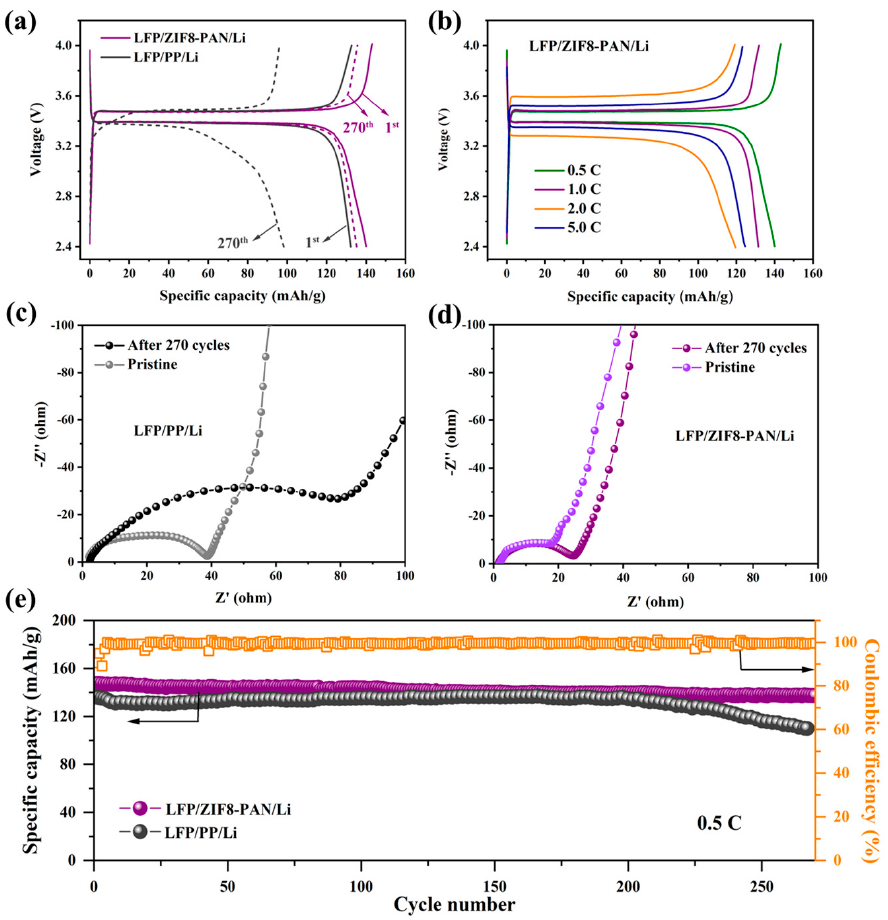
Figure 7. The electrochemical performances of Li//LiFePO 4 full cells assembled with PP and ZIF8-PAN separators. ( a ) Voltage profiles for the first and 270th cycle at 0.5 C. ( b ) Charge/discharge performance of ZIF8-PAN-based full cells under different current densities. ( c , d ) EIS results of pristine and cycled full cells. ( e ) Cyclic performance of two types of cells at 0.5 C.